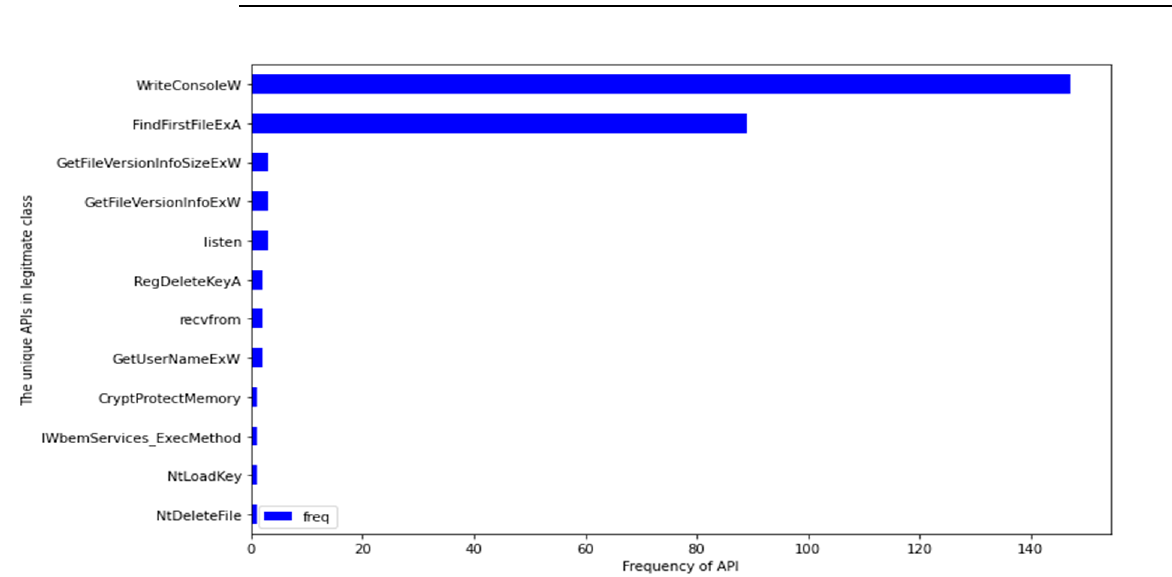
Figure 1. The unique API calls of legitimate class.